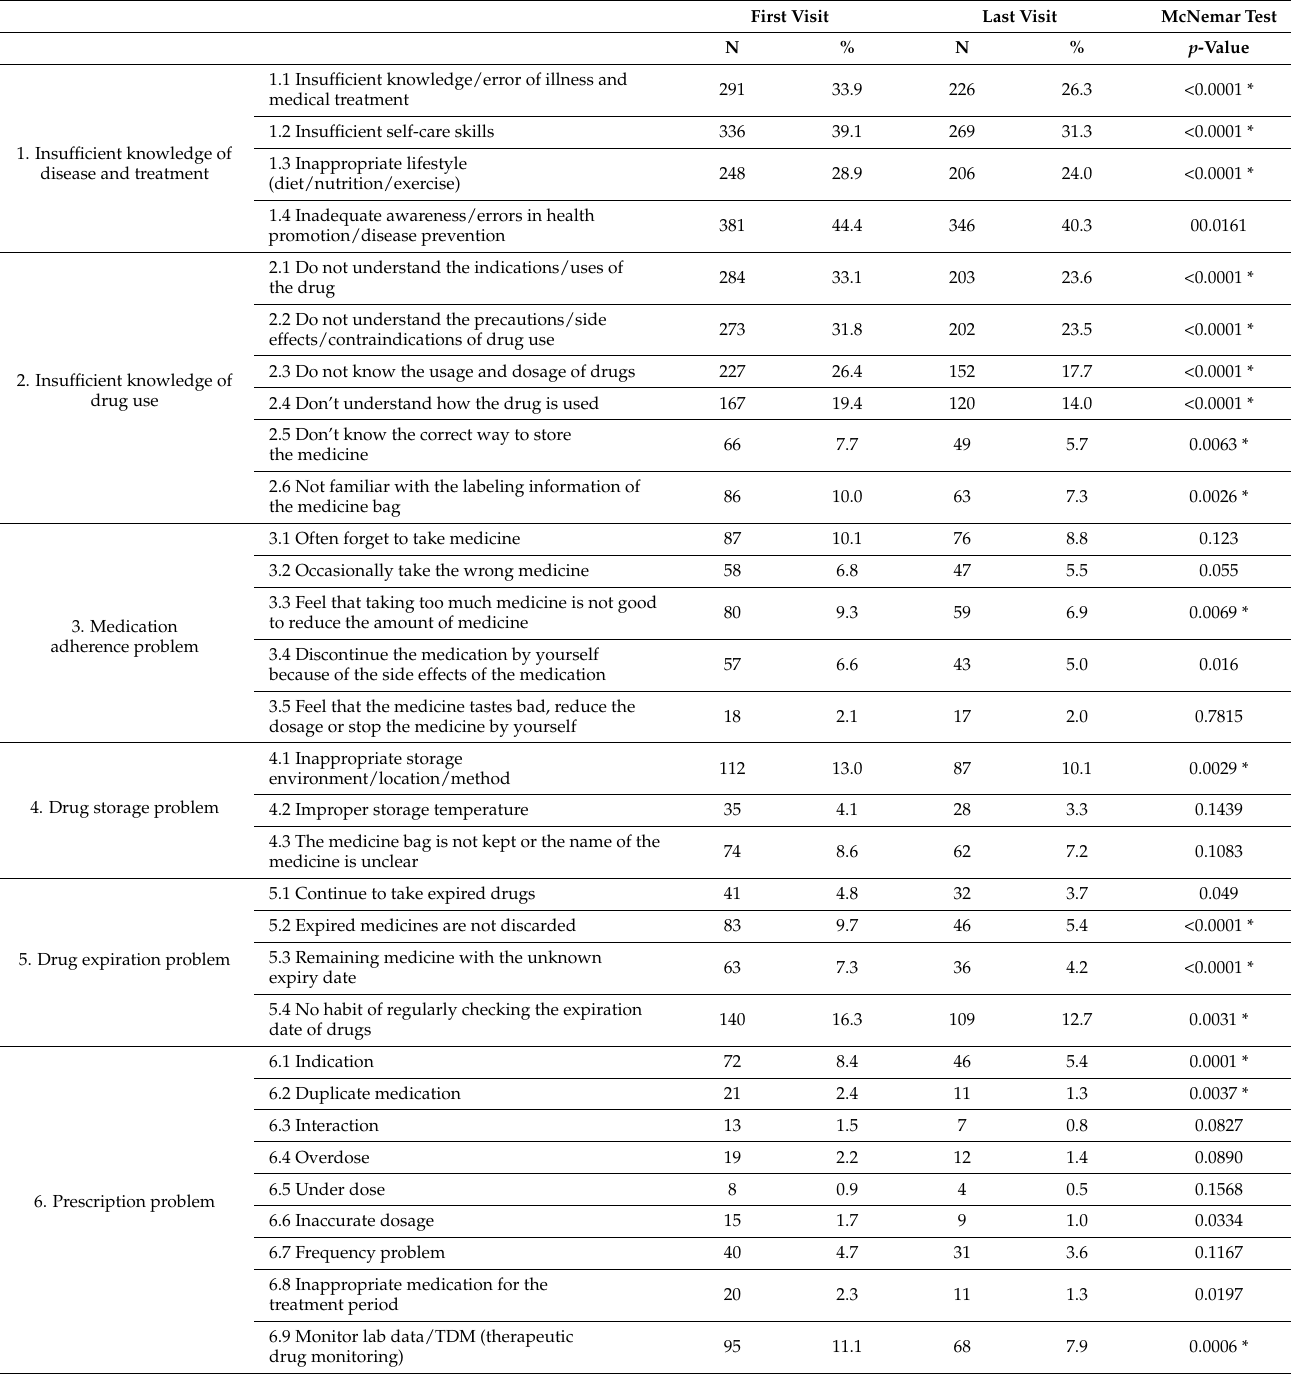
Table 4. Medication problems at the first and last home